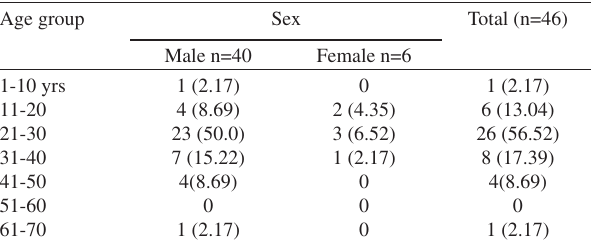
Table 4 - Distribution of patients by age and sex in relation to assault